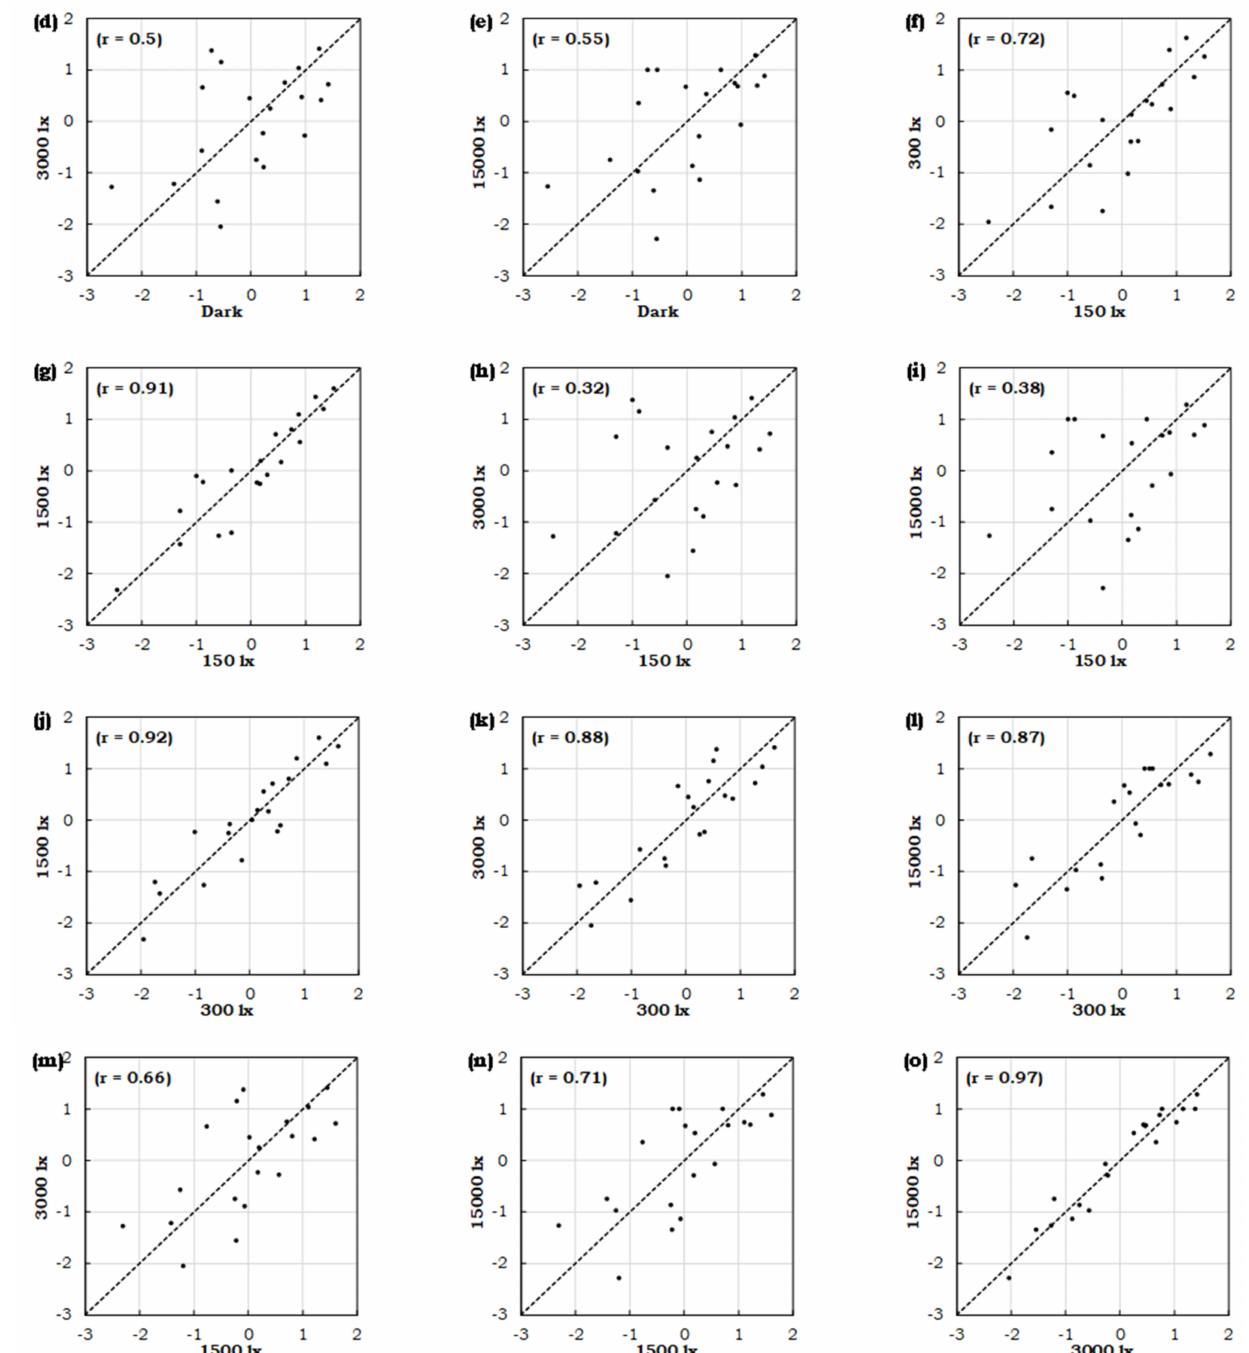
Figure 6. Correlation r between different combinations of ambient illuminance settings (Dark, 150 lx, 300 lx, 1500 lx 3000 lx, and 15,000